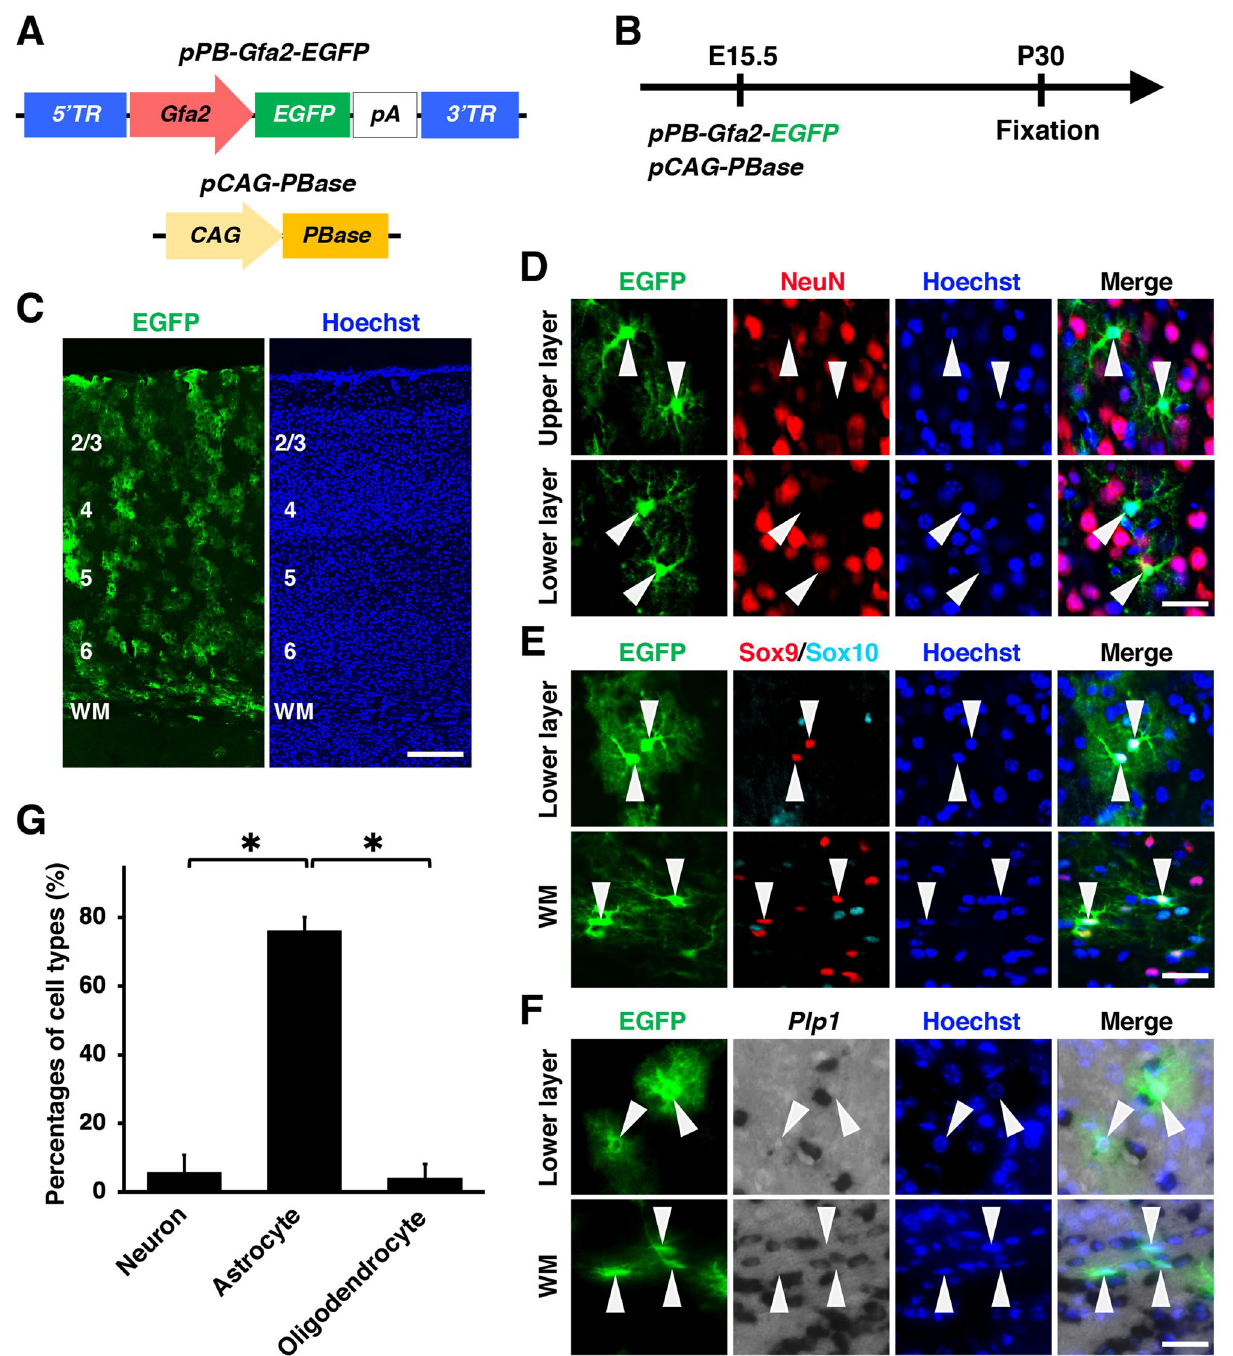
Figure 2. The Gfa2 promoter induced transgene expression in astrocytes specifically in the mouse cerebrum. ( A ) Schematics of pPB-Gfa2-EGFP and pCAG-PBase plasmids. pPB-Gfa2-EGFP drives EGFP expression under the Gfa2 promoter. ( B ) Experimental procedure. pPB-Gfa2-EGFP and pCAG-PBase were co-electroporated into the mouse cerebrum at E15.5, and coronal sections were prepared at P30. ( C ) Coronal sections of the electroporated cerebrum. Many EGFP-positive cells were distributed throughout the gray matter and the white matter. ( D – F ) Immunohistochemistry for NeuN ( D ), Sox9 and Sox10 ( E ), and in situ hybridization for Plp1 ( F ). Most EGFP-positive cells expressed Sox9 and were negative for NeuN, Sox10 and Plp1 (arrowheads). ( G ) The percentages of EGFP-positive cells which were also NeuN-positive (neuron), Sox9-positive/Sox10-negative (astrocyte) or Plp1 -positive (oligodendrocyte). The Gfa2 promoter drove EGFP expression in astrocytes selectively when combined with the piggyBac system and in utero electroporation. Unpaired Student’s t -test, * P < 0.0005. Error bars represent mean ± SD. The statistical analyses were performed using Microsoft Excel ver. 16.43. Scale bars: 200 μm ( C ), 30 μm ( D–F ). TR, terminal region; WM, white matter. Numbers indicate layers in the cerebral